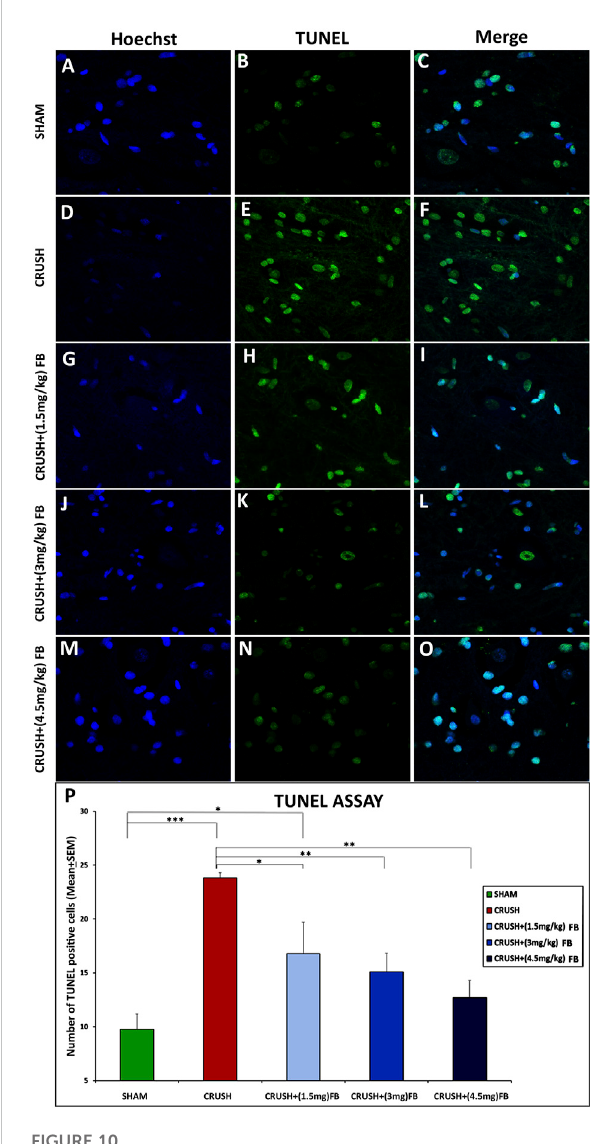
FIGURE 10 FBreduced apoptosis after sciatic nervecrushinjury.The apoptotic cellsofthespinalcordwereidenti fi edthroughaTUNELassay. (B,E,H,K , and N) Cells with a TUNEL signal are presented in (green) and counterstained with Hoechst in (A, D, G, J and M) (blue). (C,F,I,L,O) photos representing merged Hoechst and TUNEL immunop fl uorescence staining Magni fi cation ×40. (P) The number of TUNEL-positive cells within the spinal cord. CRUSH animals demonstratedahighernumberofTUNEL-positivecellswhencompared to other experimental groups. FB treatment signi fi cantly decreased the number of apoptotic cells after sciatic nerve crush injury. Data are expressed as mean ± SEM. * p < 0.05, ** p < 0.01, and *** p <